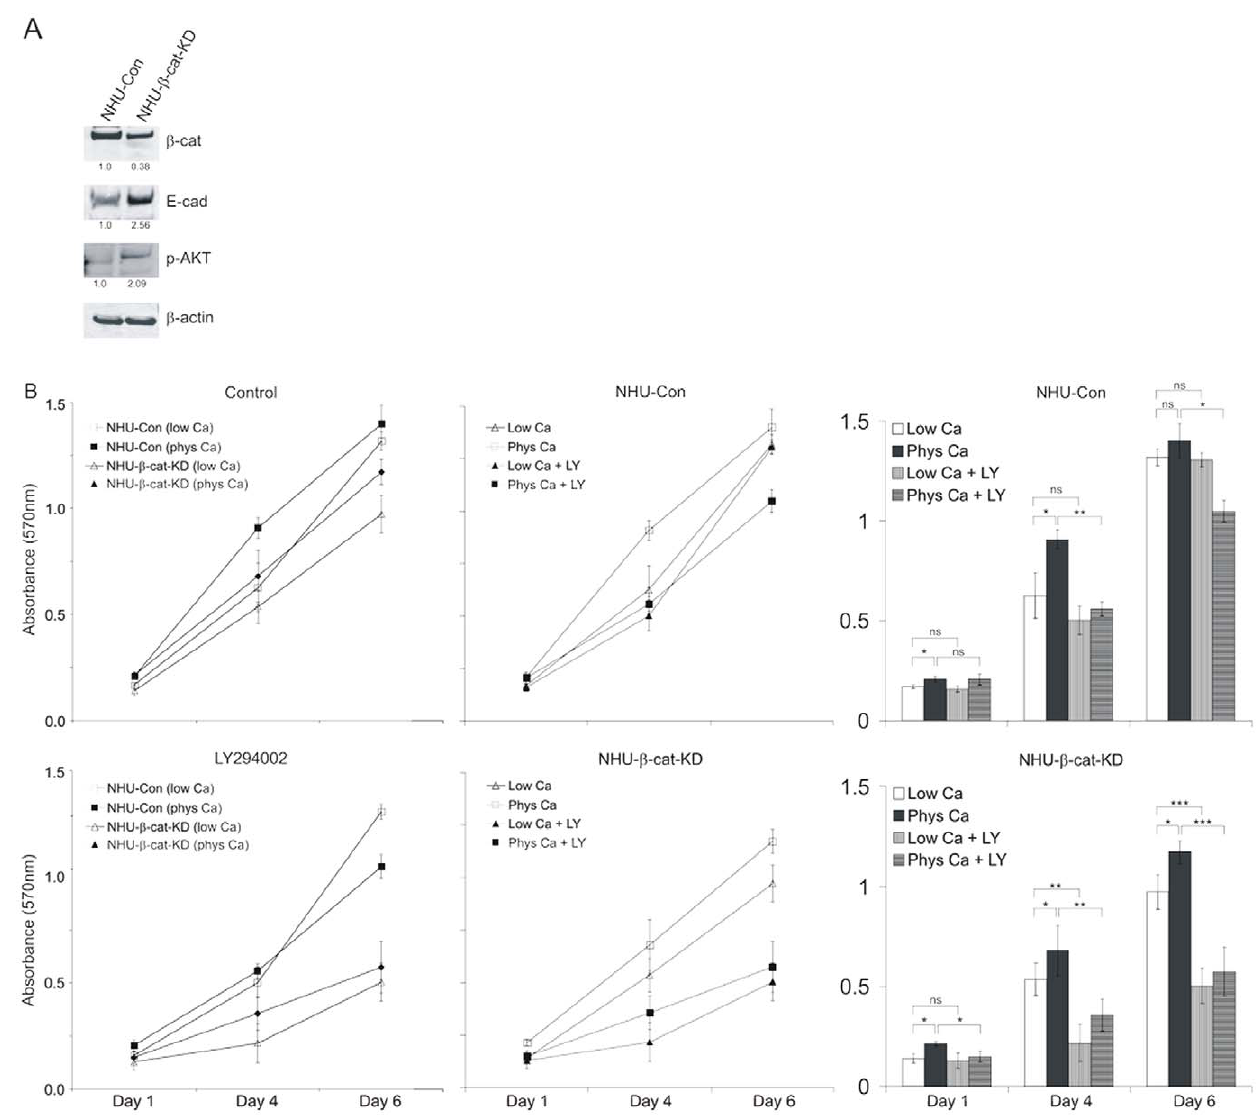
Figure 5. Loss of b -catenin by shRNA-mediated knock-down mimics E-cadherin engagement. (A) NHU cells expressing b -catenin shRNA (NHU- b -cat-KD) and their isogenic controls expressing scramble shRNA control (NHU-Con) were established by retrovirus transduction and the efficiency of the shRNA to down-regulate b -catenin was assessed by immunoblotting. Lysates from NHU-Con and NHU- b -cat-KD cells maintained in low calcium were probed for expression of active b -catenin ( b -cat), E-cadherin (E-cad), phospho-AKT at S437 (p-AKT) and b -actin using mouse antibodies ( b -cat, E-cad and b -actin) and rabbit antiserum (p-AKT), followed by goat anti-mouse antibody conjugated with Alexa Fluor 680 or goat anti-rabbit antibody conjugated with IRDye 800 as appropriate. Densitometry was performed to determine differences in protein expression with respect to b -actin and fold differences following normalisation are indicated. (B) NHU-Con and NHU- b -cat-KD cell lines were seeded into 96-well plates and cultured for a period of 6 days in medium containing either 0.09 mM (Low Ca) or 2.0 mM (Phys Ca) calcium concentration and in the absence (Control) or presence of 5 m M of PI3-K inhibitor LY294002. Proliferation was determined on the basis of cell biomass using the MTT assay and results are presented in upper and lower left panels. Data points represent mean absorbance values for 6 replicate wells ( 6 S.E.M.). To allow easier comparison between inhibitor-treated ( + LY) and non-treated cells, graphs for each cell line are also presented (upper and lower middle panels). In addition, results for all data points are shown in the form of bar graphs (lower panel) for the purpose of statistical analysis. ns, non-significant; *, P , 0.05; **, P , 0.01; ***, P , 0.001.